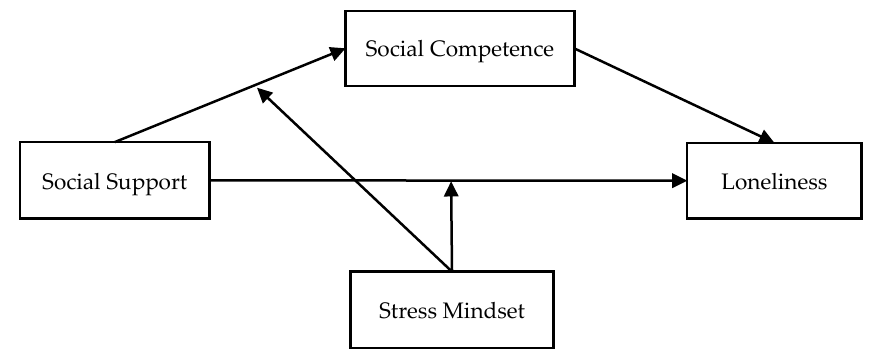
Figure 1. The proposed moderated mediation